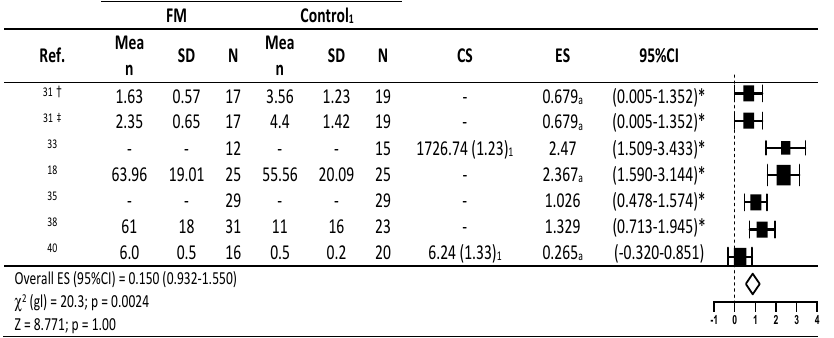
Figure 3. Descriptive statistics and forest plot of effects of fibromyalgia treatment interventions on pain tolerance threshold and pressure pain threshold. CS = contrast statistic; 1: F (gl): Snedecor contrast F statistic (degrees of freedom); a: η 2: Eta squared; †: PPT pressure pain threshold (in